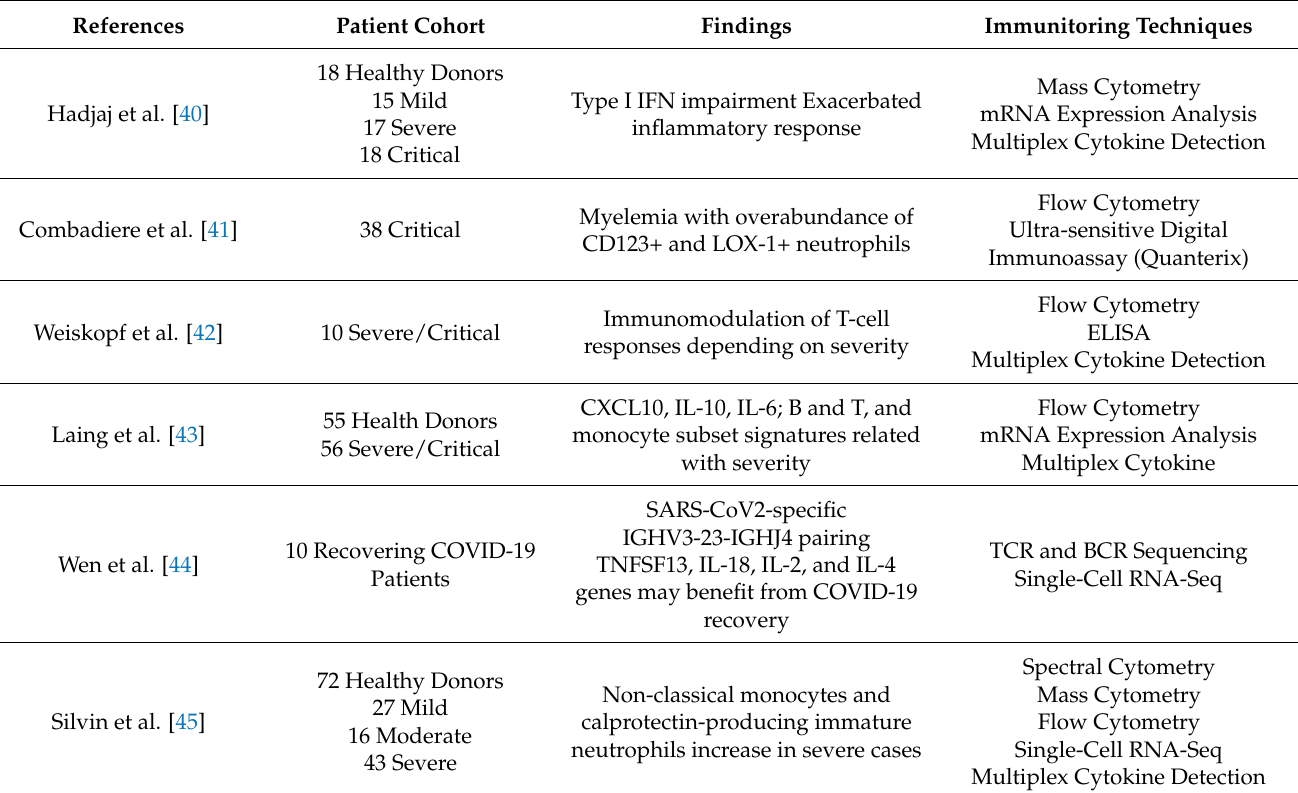
Table 1. Overview of the immunomonitoring approaches used in SARS-CoV-2 infection.